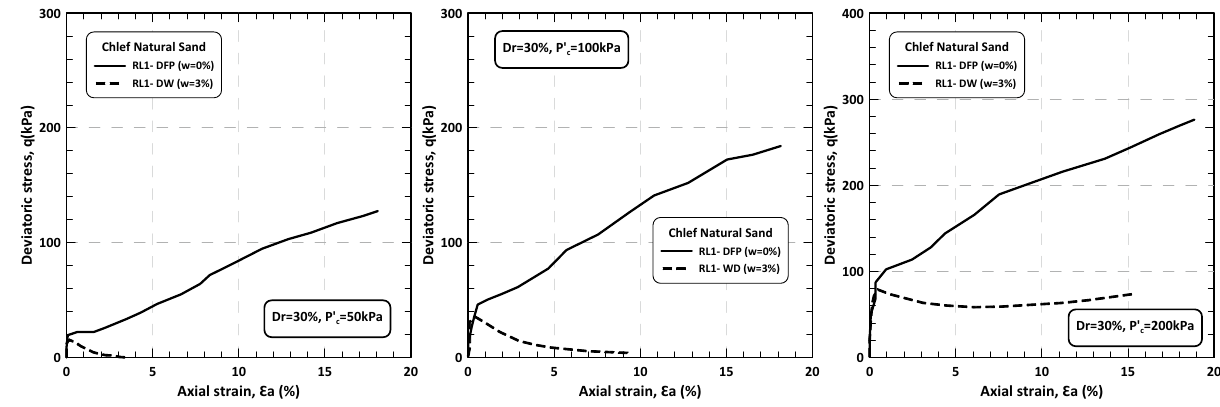
Fig. 8 Deviator stress versus axial strain curves of sand samples reinforced with one layer of geotextile under different confining pressures: a p ′ = 50 kPa, b p ′ = 100 kPa, and c p ′ = 200 kPa c c c